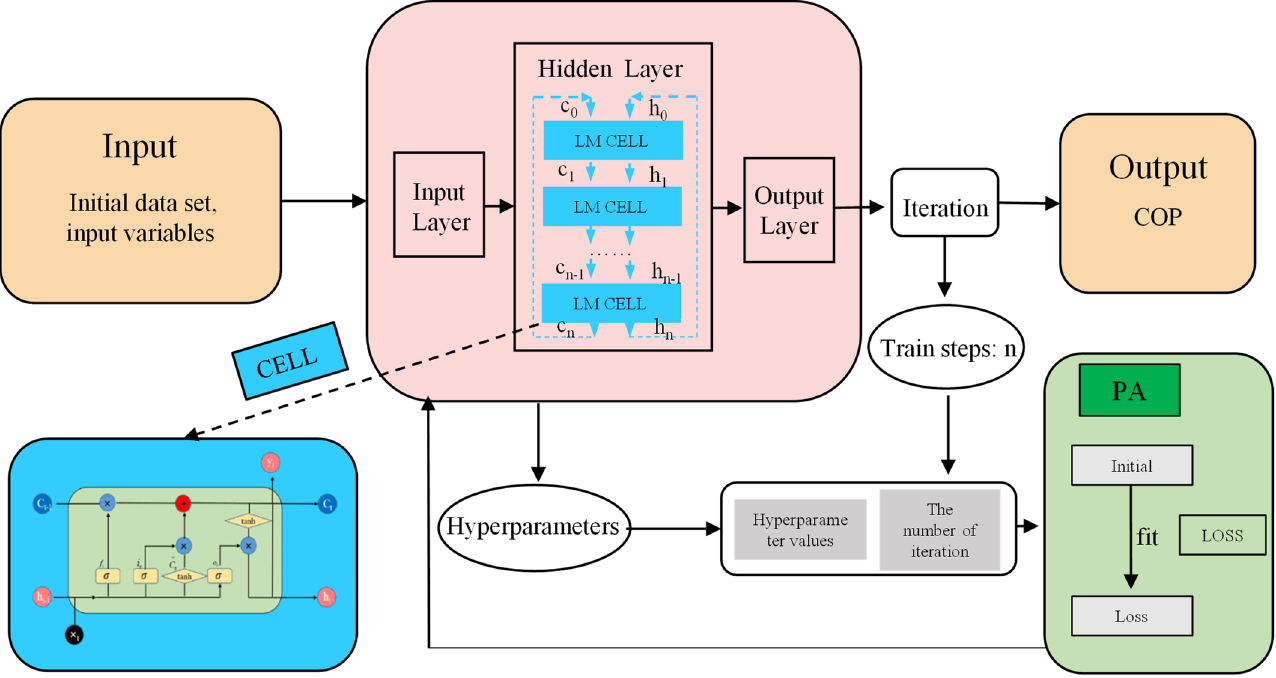
Figure 5. The establishment process of the PA-LM model.